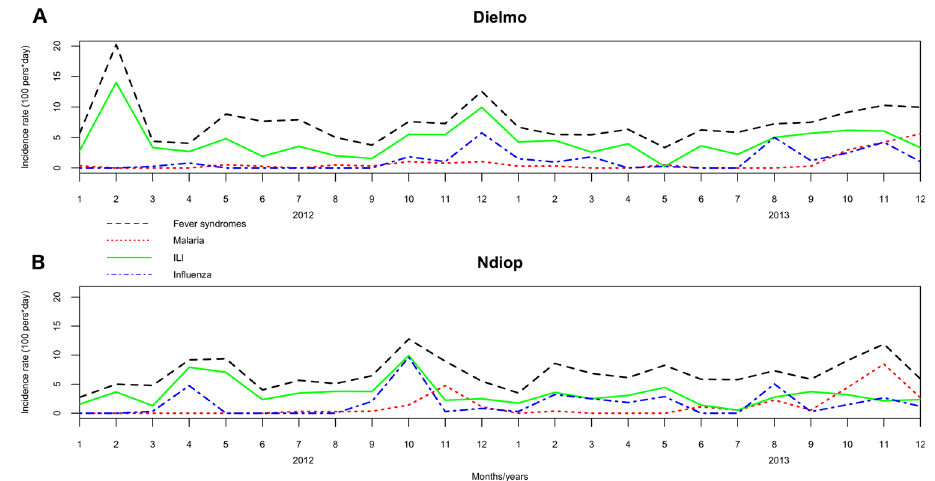
Fig 1. Overall monthly incidence density rates for the two villages, 2012 – 2013.